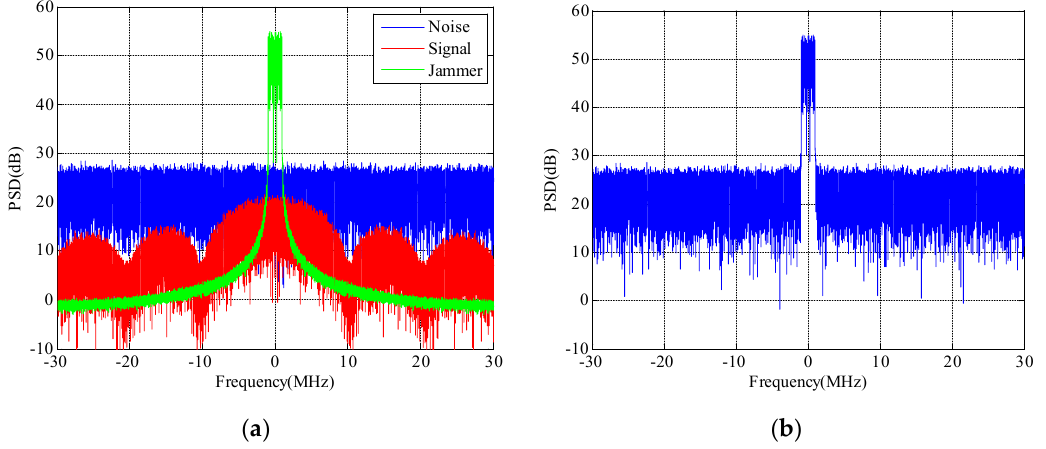
Figure 1. Spectrum comparison of interference, signal and noise. ( a ) Independent shown, ( b ) Synthetic shown.